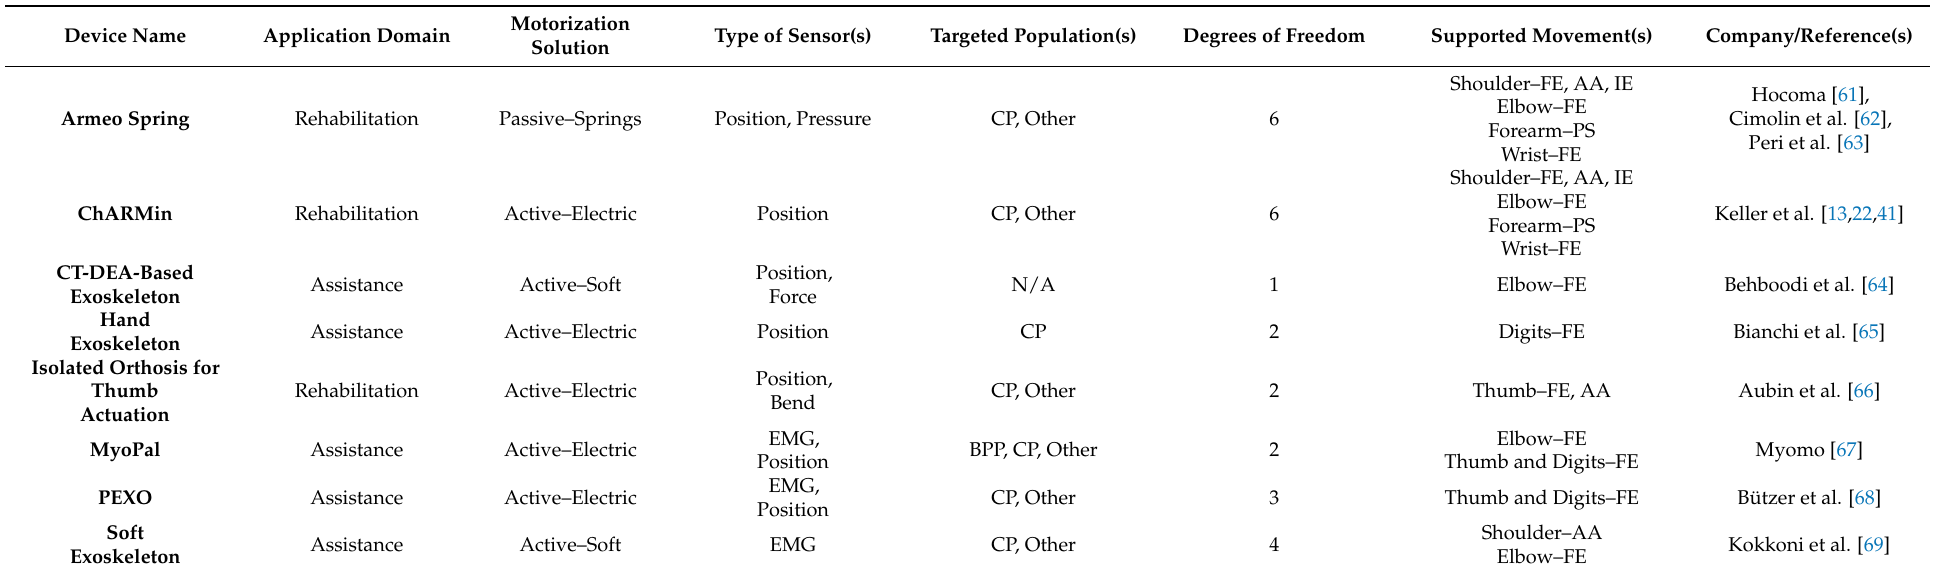
Table 2. Sensor-based upper limb exoskeletons in